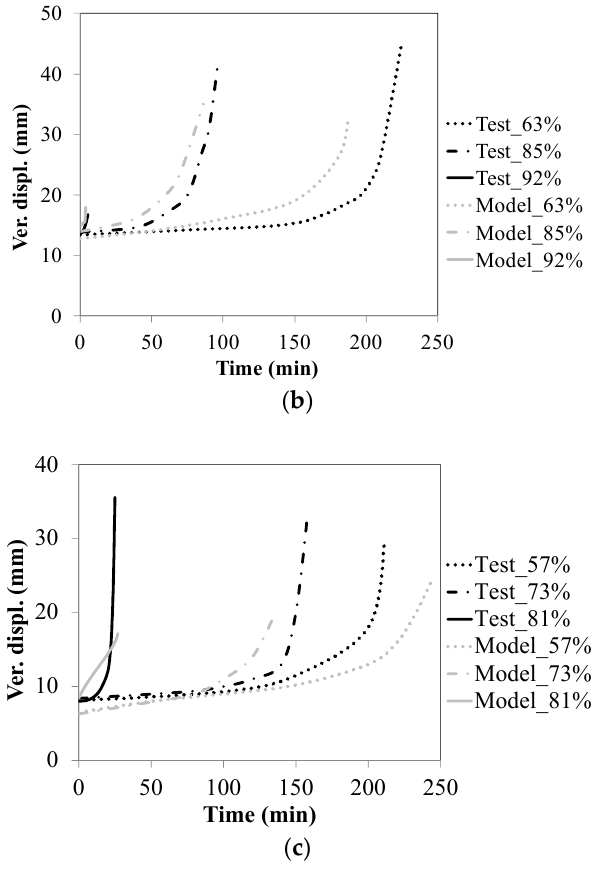
Figure 7. Results of creep tests and comparison with the Vulcan model: ( a ) 400 °C; ( b ) 500 °C; and ( c ) 600 °C.